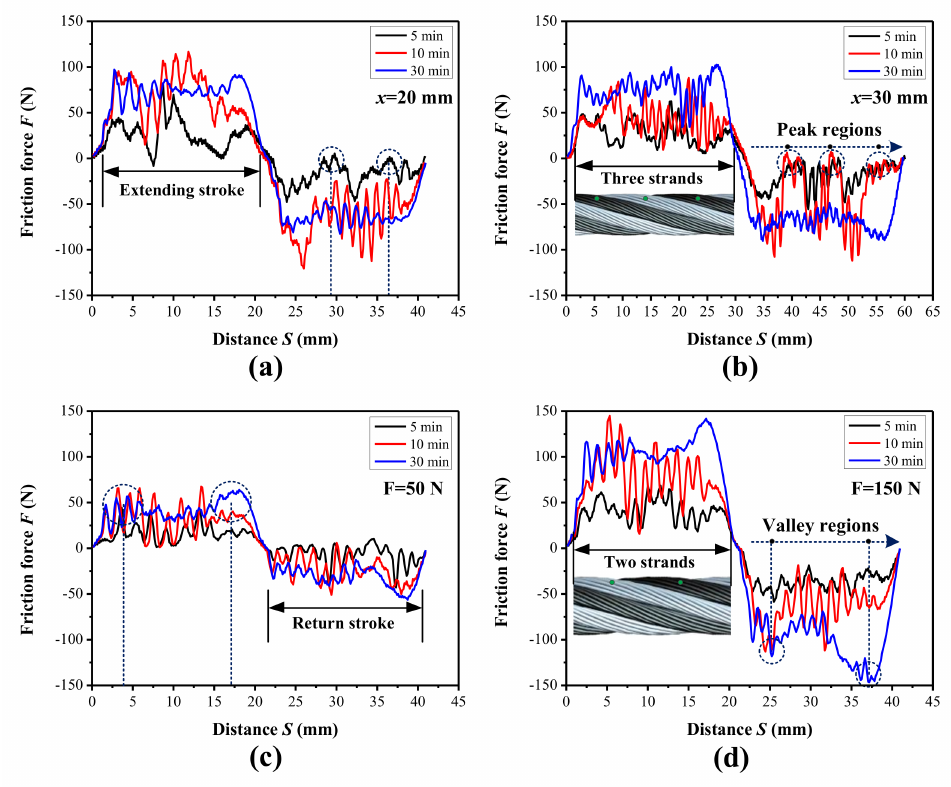
Figure 3. The evolution of friction force over one cycle for different periods. ( a ) Stroke: 20 mm, load: 100 N; ( b ) stroke: 30 mm, load: 100 N; ( c ) load: 50 N, stroke 20 mm; ( d ) load: 150 N, stroke: 20